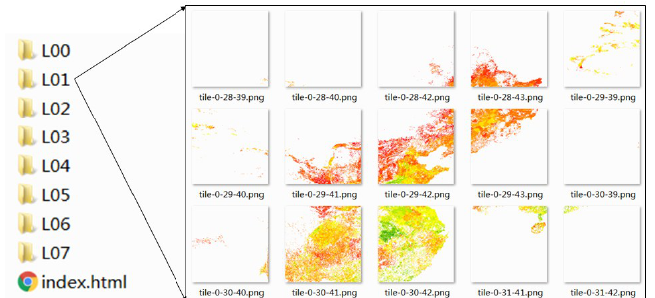
Figure 15. The map tiles of the national arable land quality dataset.